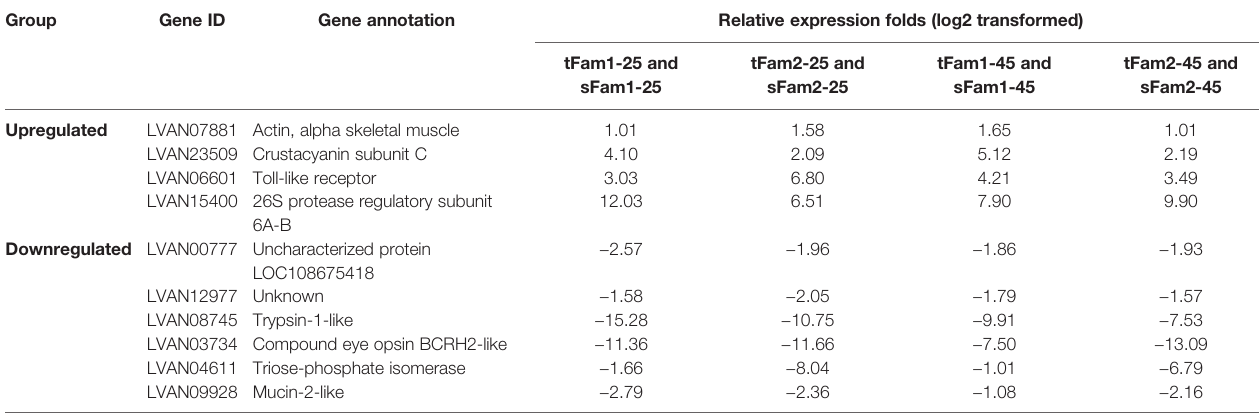
TABLE 2 | DEGs between tolerant families and susceptible families under both normal and high-salinity conditions. Group Gene